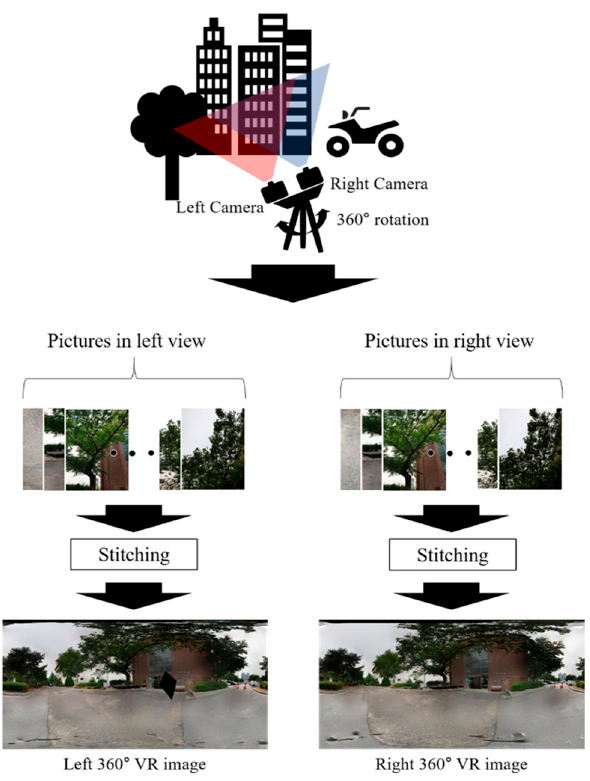
Figure 1. Procedure to make stereo 360 VR images consisting of left and right equi-rectangular projections